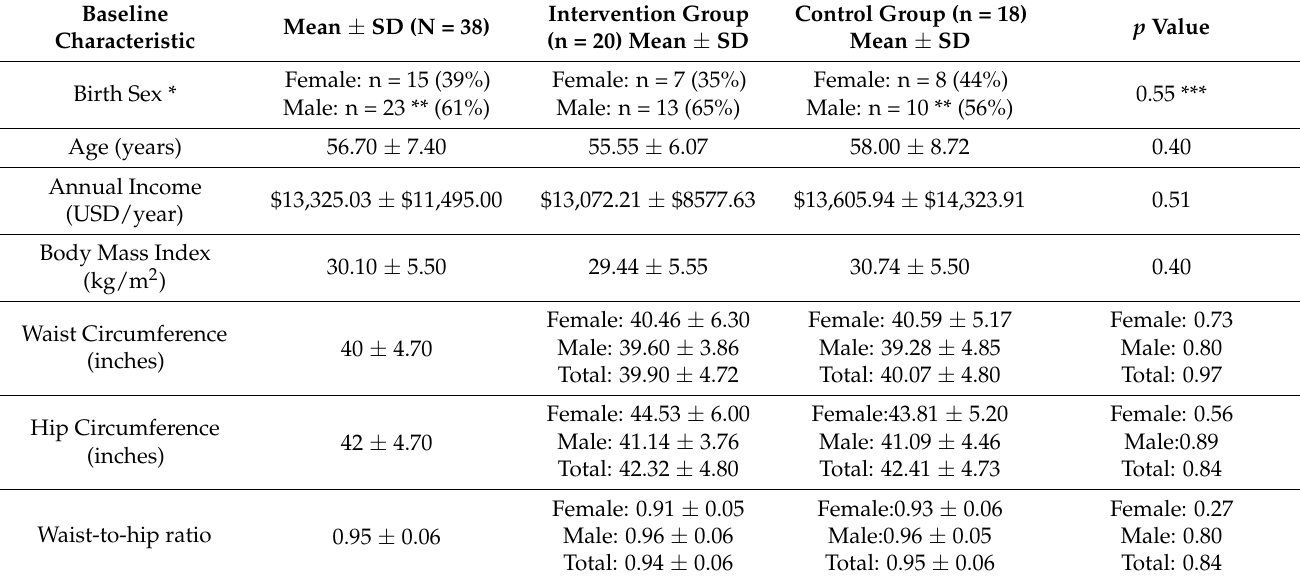
Table 2. Study Sample Baseline Characteristics of People Living with HIV and Prediabetes Participating in a 6-Month Nutrition Intervention to Progress through Stages of Change for Health-Related